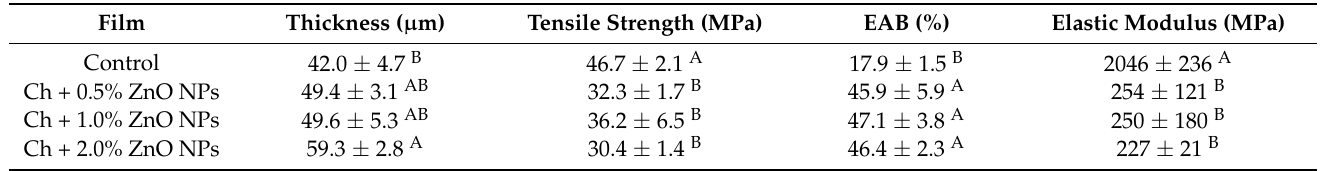
Table 1. Thickness and mechanical properties